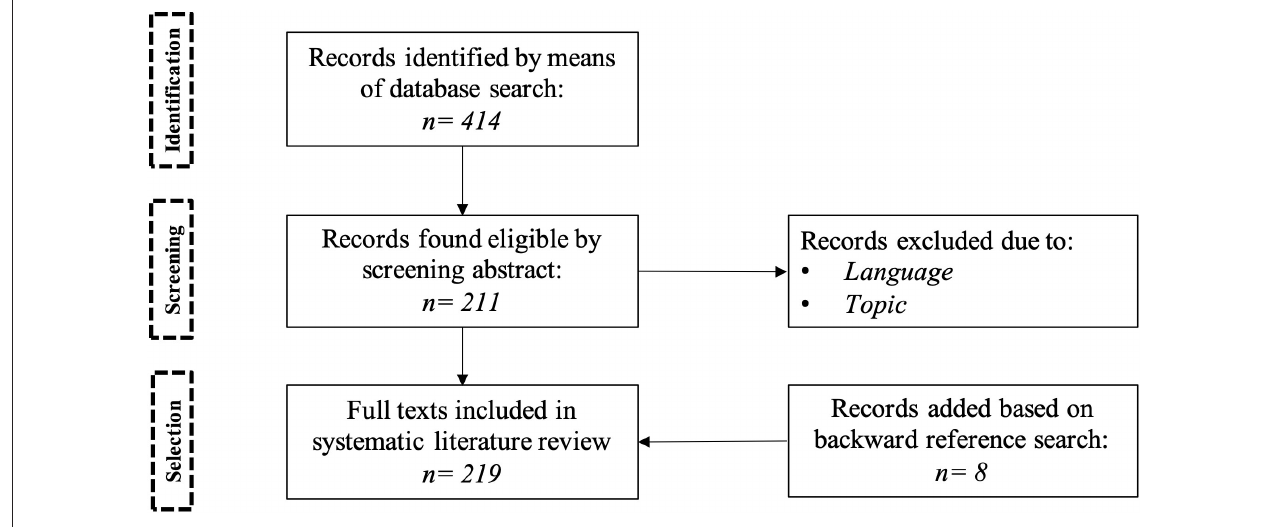
FIGURE 1 | Overview of review methodology.